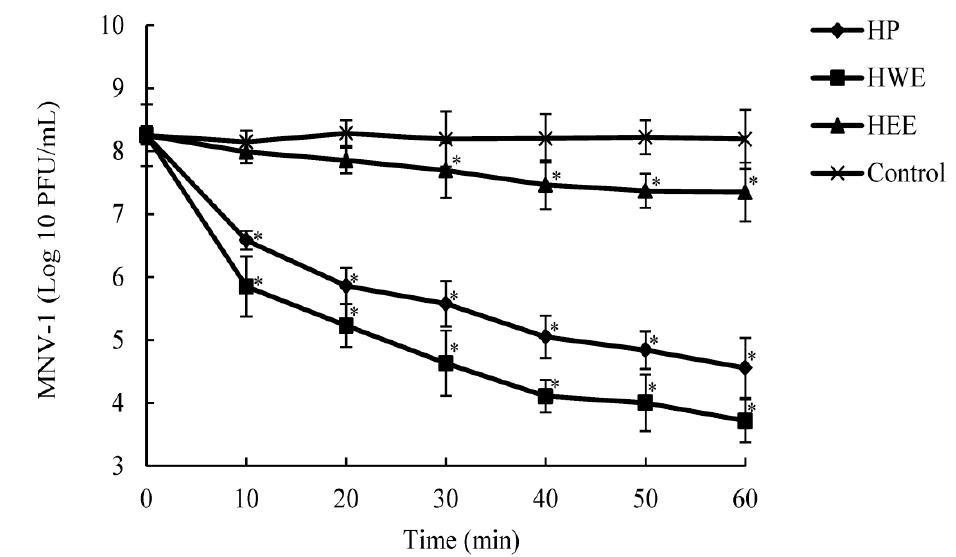
Figure 4. Change of MNV-1 titers versus incubation time after exposure to HP, HWE or HEE. Two-hundred-and-fifty ( µ g / mL) of HP, HWE or HEE solutions were added to an equal volume of MNV-1 at titer of ~8 log10 PFU / mL and incubated for up to 60 min at room temperature. The MNV-1 was recovered at 0, 10, 20, 30, 40, 50, and 60 min and assayed for its infectivity using standardized plaque assay. Each experimental condition was analyzed in triplicate. All data were expressed as mean ± standard deviation. Significant di ff erences with control group are designated as * p ≤ 0.05.